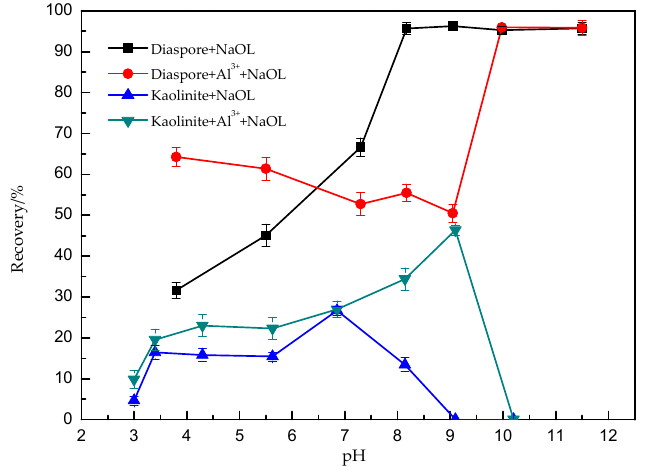
Figure 3. Flotation recoveries of diaspore and kaolinite with and without backwater Al 3+ (Al 3+ : 1 × 10 − 4 mol/L; Sodium oleate (NaOL): 5 × 10 − 4 mol/L).